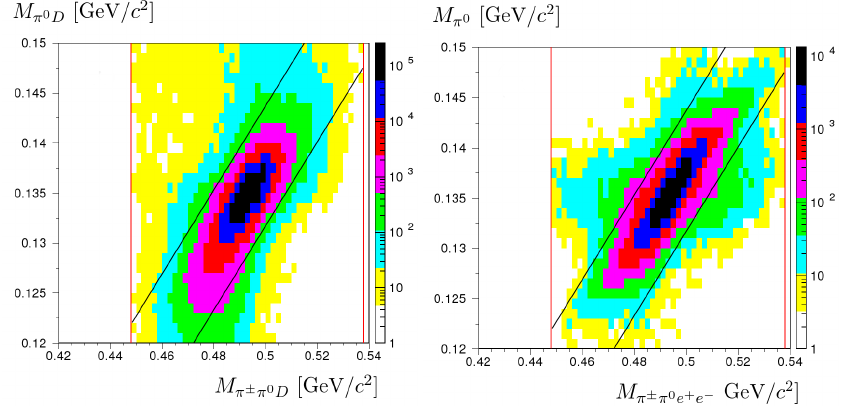
Figure 3. Left plot: normalization simulated candidates in the plane of reconstructed masses ( M , M ). Right plot: signal simulated candidates in the plane of reconstructed masses π ± π 0 D π 0 D ( M , M ). The vertical lines and the slanted bands correspond to the selection constraints. π ± π 0 e + e − π 0 Both signal and normalization candidates are reconstructed from three-track vertices with the track reconstructed momenta in the range (2–60) GeV / c. The tracks are required to be in time within 5 ns of each other using the HOD time associated to each of the considered